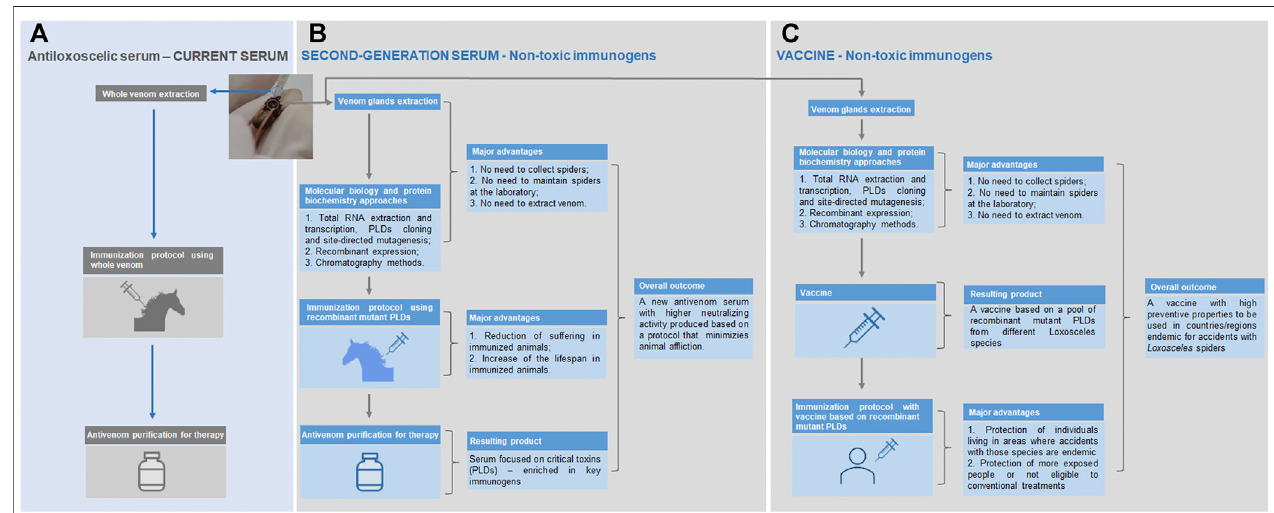
FIGURE 1 | Current antivenom therapy (antiloxoscelic serum) and the new approaches using non-toxic immunogens (second-generation serum and vaccine). (A) The current serum is produced using the whole venom extracted by a quali fi ed staff from spiders captured in nature; the immunized animals to produce the serum develop unwantedreactionsderivedfromthewholevenomtoxicity(painandswellingattheinoculationsiteand,insomecases,suppuration;inappetenceandepisodes of mild and transient fever may appear); although the current protocol is well established, it is subjected to a certain irreproducibility, since the yield of venom extractions can vary and this could have a negative impact on the periodic animals ’ immunization procedures. (B) The strategy regarding the second-generation serum combinescostsaving(noexpensesrelatedtospidercollectionmissionsandmaintenanceoftheseanimalsincaptivity),staffsafety(norecurrentmanipulationofspiders) andeasymanagementoftheproductionprocess(itdoesnotdependontheef fi ciencyofthewholevenomextraction);mostimportantly,themethodforthegenerationof the new antivenom assures the depletion of adverse signs and symptoms in the immunized animals (mutant PLDs used are not tissue-destructive as the native PLDs) and the serum ef fi cacy isexpected tobe higher, sinceitis produced using the molecules responsiblefor most ofthe noxious effects seenin the loxoscelism — the PLDs. (C) The development of a vaccine based in recombinant mutant PLDs from different Loxosceles species will be important for the protection of individuals living in areas where accidents with those species are endemic, as well as in people more exposed or not eligible to conventional